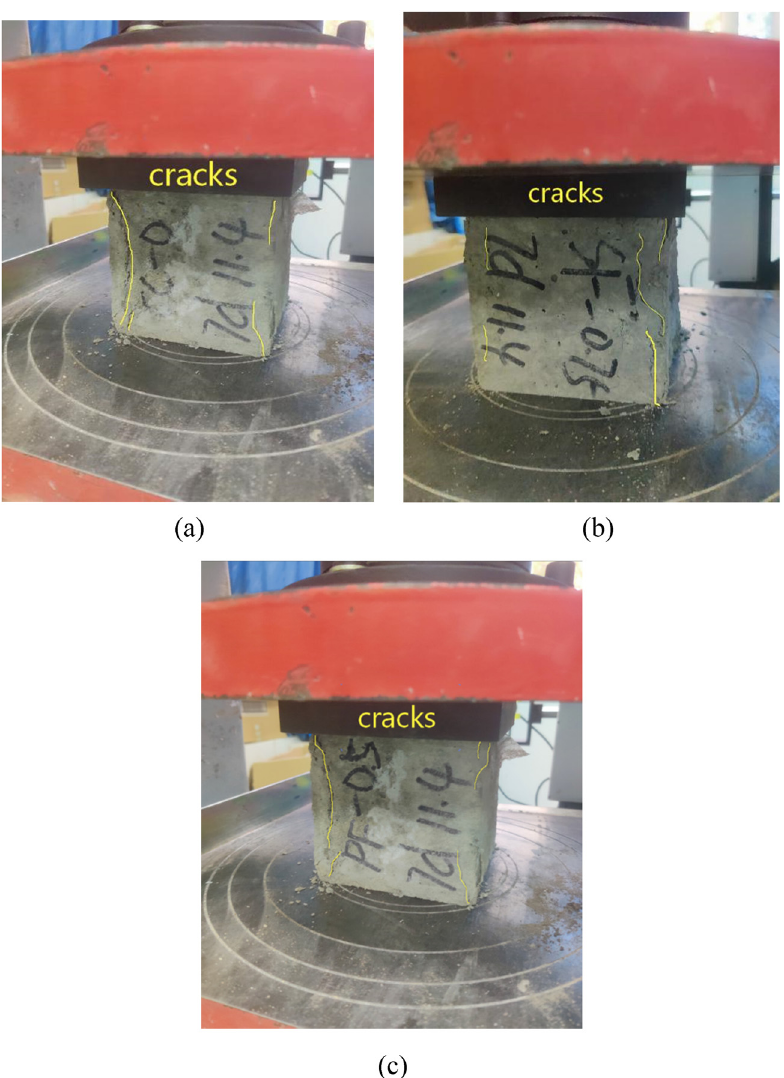
Figure 7: Control groups. ( a ) BFCGGPC, ( b ) SFCGGPC, and ( c )